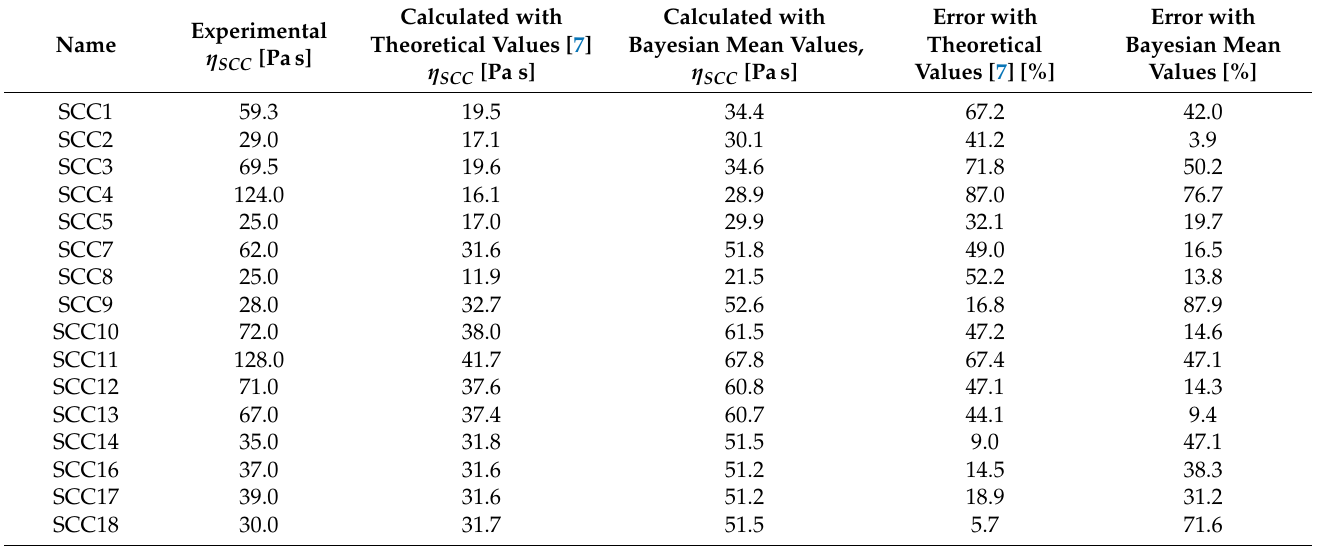
Table 9. Comparison between experimental values and models, and error estimated for self-compacting concrete (Es- maeilkhanian et al.